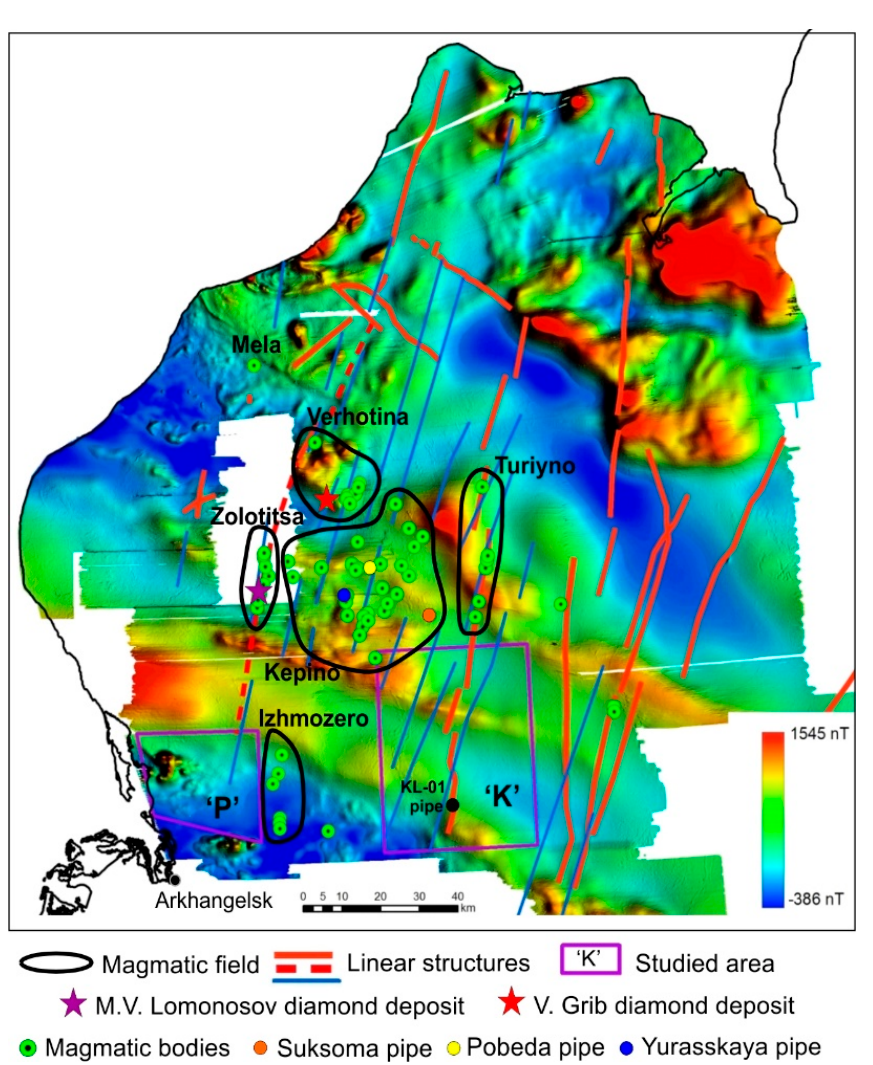
Figure 2. Map of anomalous magnetic field Δ T for the Arkhangelsk Diamondiferous Province (ADP) and location of the KL-01 pipe. Adapted from [1].